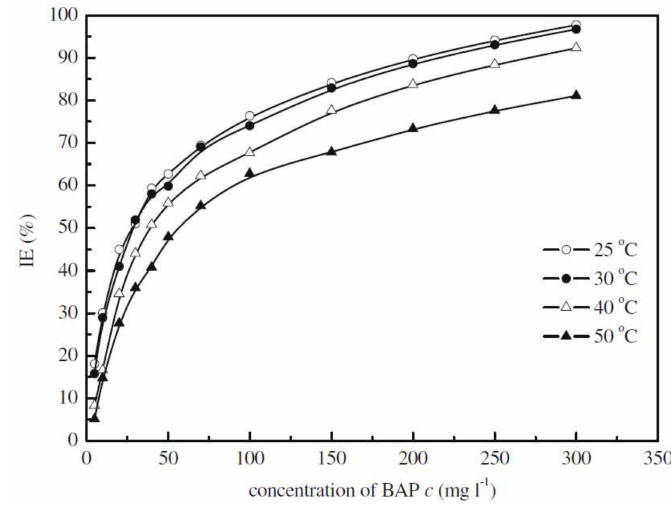
Figure 6. Relationship between inhibition efficiency (IE) and BAP concentration in 1.0 M H 2 SO 4 [76].